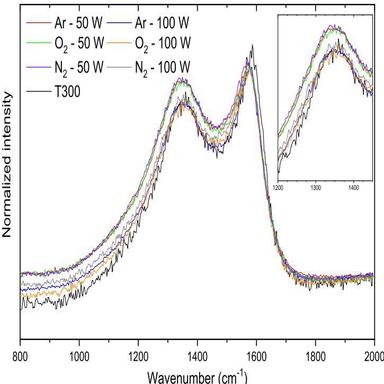
Dependence of the G band shift (black) and the ID/IG area ratio on a) the applied power (t = 5 min); b) the exposure time (P = 40 W) for O2 plasma-treated CF.